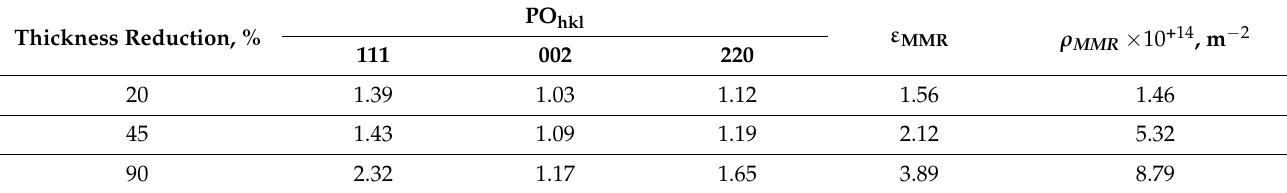
Figure 5. Mechanical properties of Al/1 wt% CNT: ( a ) engineering stress- strain curves; ( b ) the corresponding strain hardening rate vs. true strain. Table 1. Texture parameter, total imposed strain, and dislocation